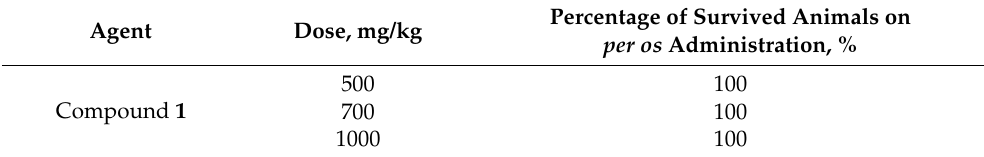
Table 11. Compound 1 tested for acute toxicity at different doses in animal